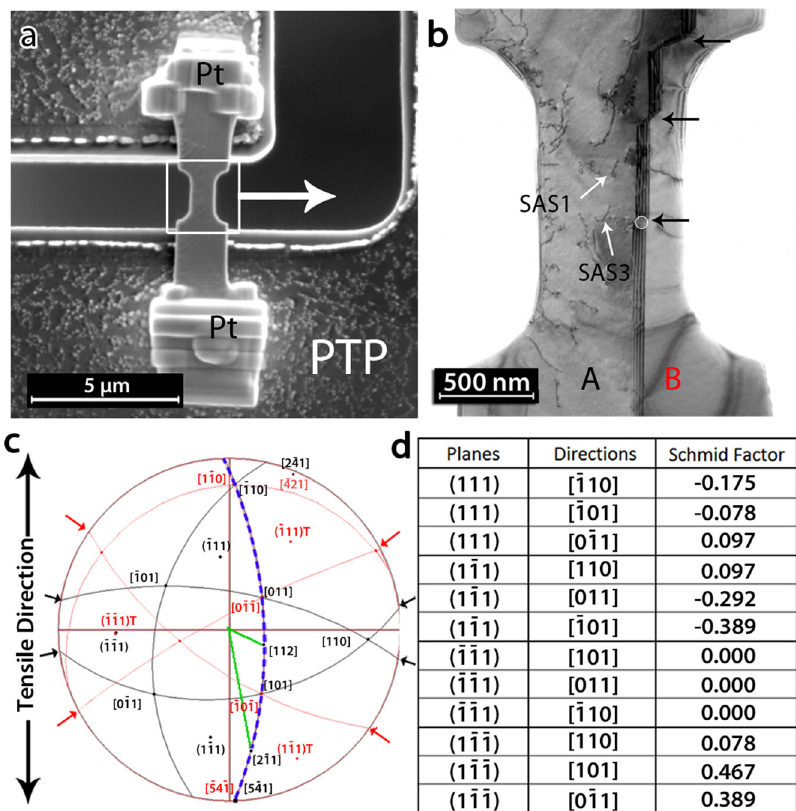
Fig. 1 Sample preparation for quantitative in-situ TEM tensile testing. a SEM micrograph showing the sample mounted on a Push-to-Pull (PTP) device, see more information in the “ Methods ” section and the supplementary information. b Bright fi eld TEM micrograph of the sample before deformation (white square and arrow in a ). The white circle indicates the location of a TB ledge used as a reference in Fig. 2. Single arm sources SAS1 and SAS2 are indicated by white arrows while the black arrows show the position of ledges at the CTB. c Overlapped stereographic projections of grains A (black) and B (red). The TB plane ð (cid:1) 1 (cid:1) 11 Þ or ð (cid:1) 1 (cid:1) 11 Þ T , is marked by a blue dashed line. d Schmid factor values of the slip systems in both grains. The two slip planes with the highest Schmid factor, ð 1 (cid:1) 1 (cid:1) 1 Þ and ð 1 (cid:1) 11 Þ , are marked with black and red arrows, respectively, in c . Fig. 2 Transition from transmission to absorption of screw dislocations. Snapshots from the Supplementary movie 1 of cycle 2, showing the dynamic of SAS1 a just before activation, and b – d at different times during deformation. The yellow (resp. white) arrows indicate the freshly formed ST in grain A (resp. grain B). Red segments in b are used to indicate the connection between STs in both grains (see also the schematic in e ). Note that the Burgers vector of the dislocation of the SAS is parallel to the intersection between the gliding plane of the dislocation and the CTB plane. Red arrows show the formation of fringe-like contrast at the CTB indicating the absorption of the incoming dislocations at the CTB (see the schematic in f ). The white dot shows the location of the TB ledge used as a reference.